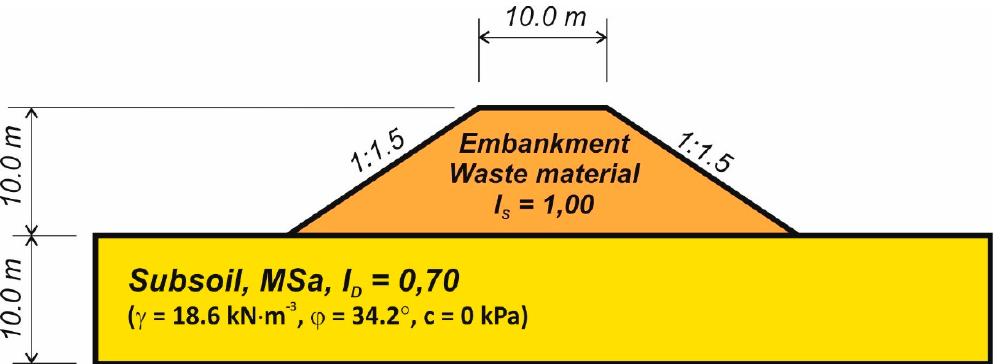
Figure 2. Scheme of the calculation model of the embankment with slope inclination of 1:1.5.